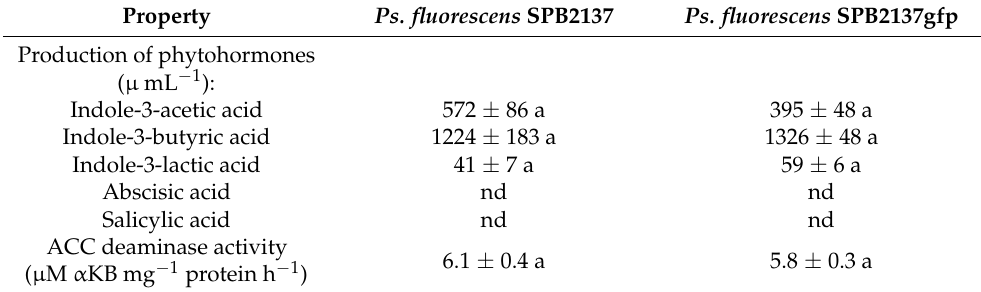
Table 1. Properties of Ps. fluorescens SPB2137 and its GFP-tagged variant, SPB2137gfp. Property